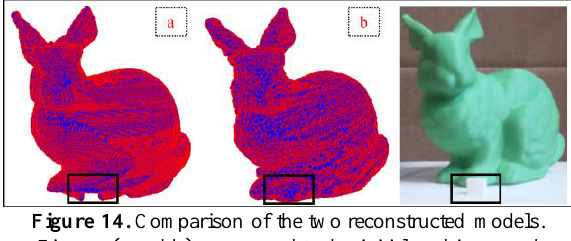
Figure 14. Comparison of the two reconstructed models.